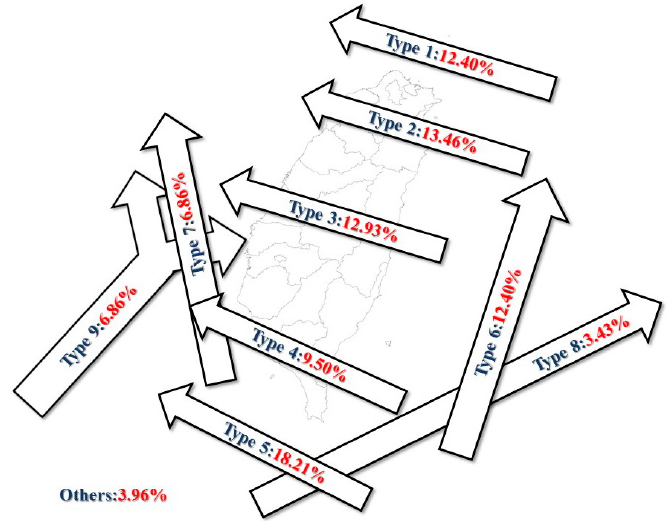
Figure 2. Types of typhoon paths and the percentage of occurrence (1911–2017) [29].